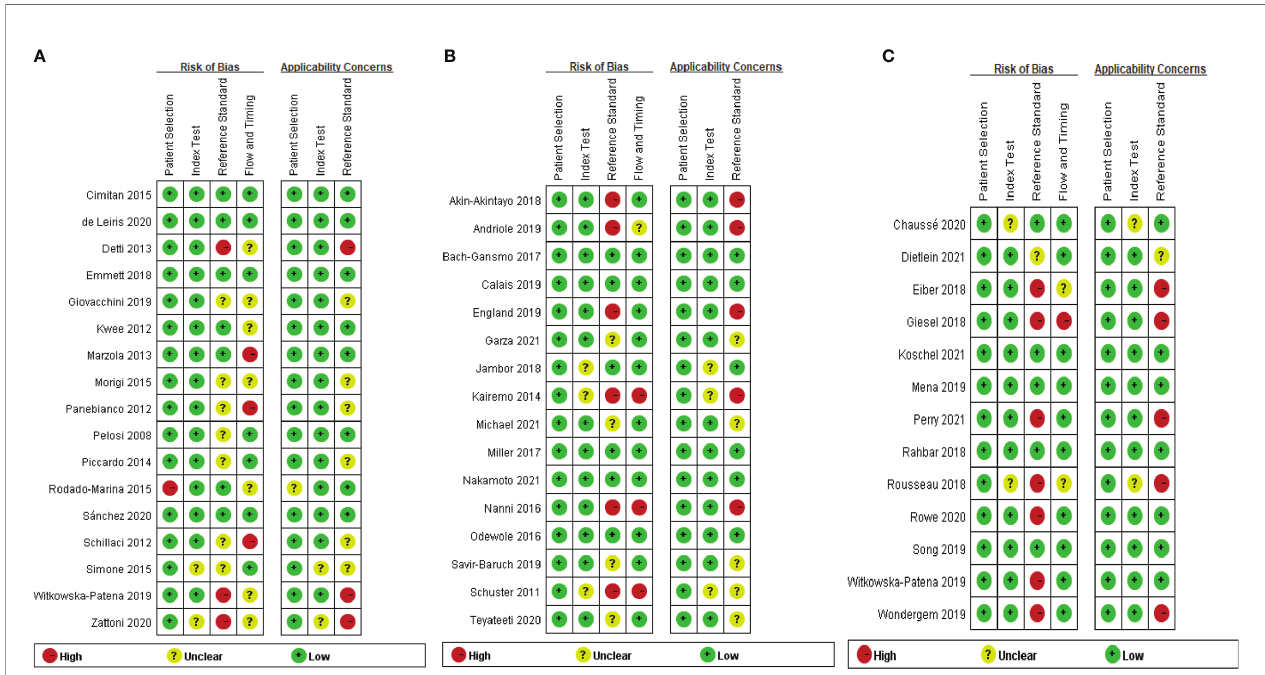
FIGURE 2 | (A) Quality Assessment of Diagnostic Accuracy Studies-2 analysis of study bias in 18 F-choline cohort. (B) Quality Assessment of Diagnostic Accuracy Studies-2 analysis of study bias in 18 F- fl uciclovine cohort. (C) Quality Assessment of Diagnostic Accuracy Studies-2 analysis of study bias in 18 F prostate-speci fi c membrane antigen (PSMA) cohort.